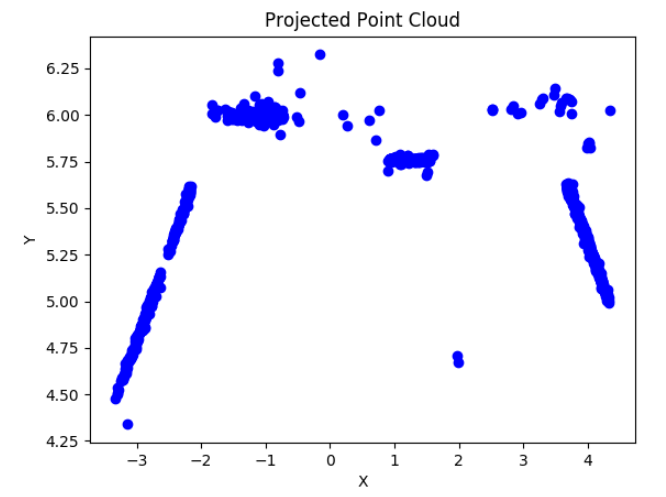
Figure 3. Top view projection of the unscaled point cloud from